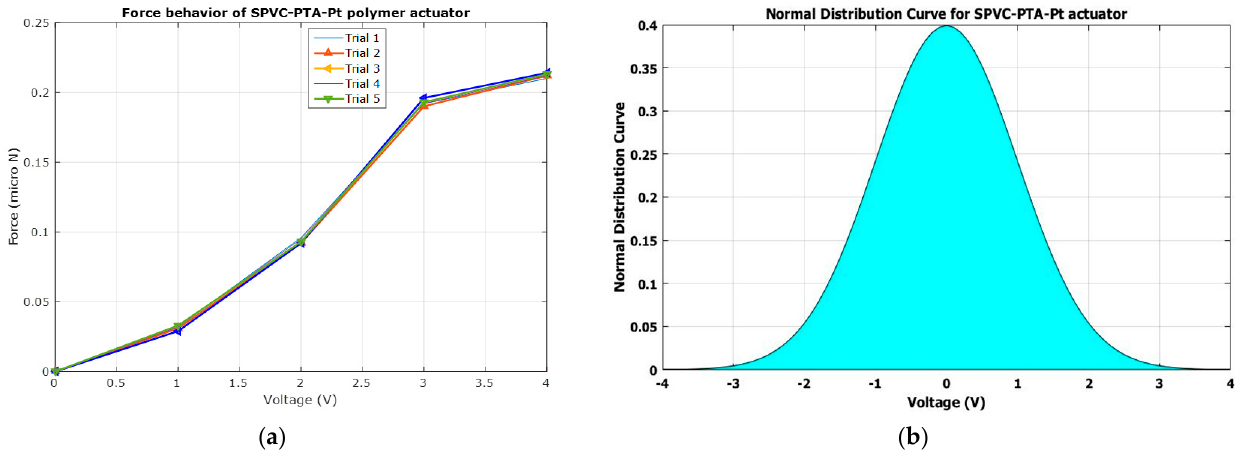
Figure 12. ( a ) The actuation force behavior of the SPVC–PTA–Pt bending actuator; ( b ) normal distribution behavior of the SPVC–PTA–Pt bending actuator.